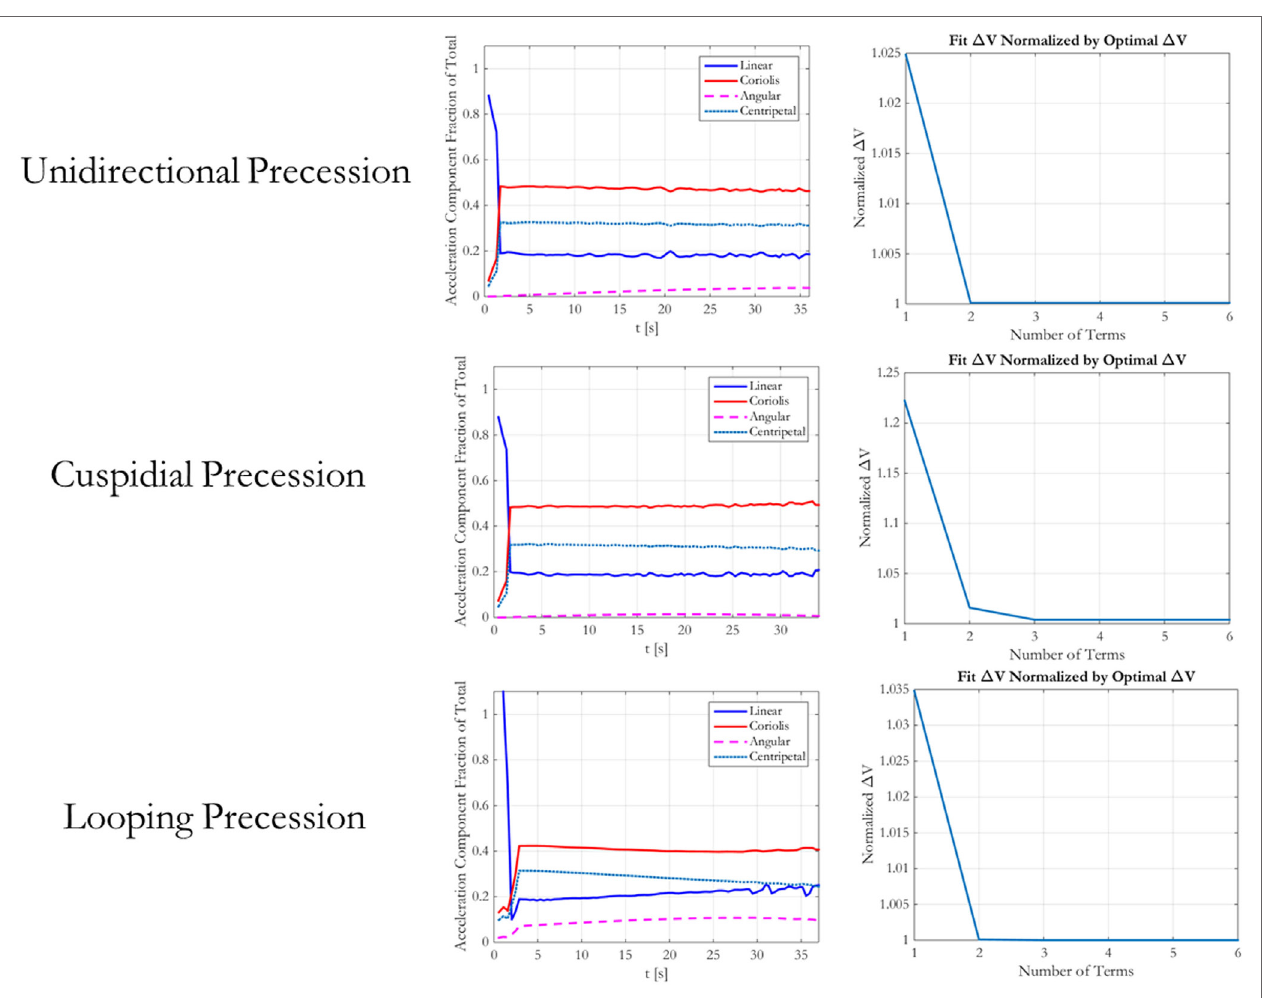
FigUre 9 | Fitting increasing number of exponential terms to various tumble types.